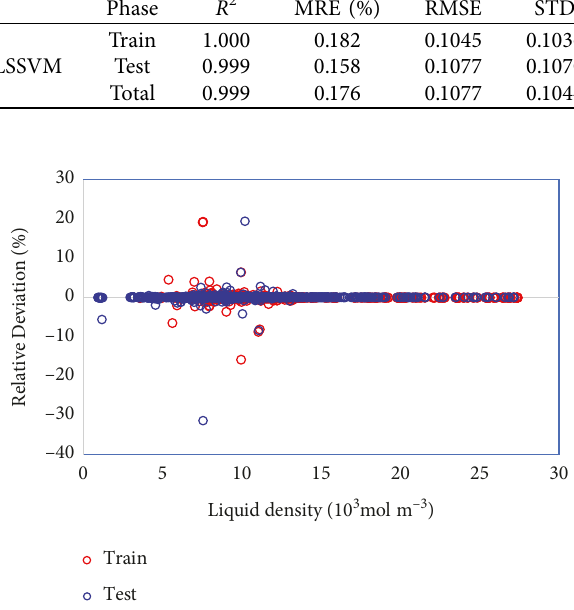
Figure 4: Relative deviation (%) of testing and training data using the LSSVM model.